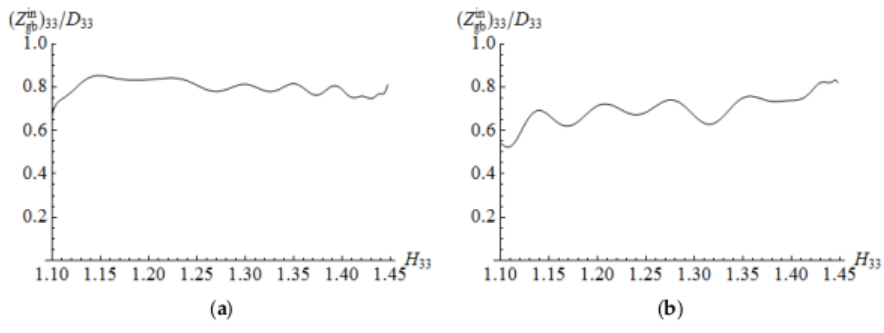
Figure 5. Inelastic strain rate values obtained at the expanse of the GBS ( Z in current strain rate D 33 and determined at equal intervals of the strain H 33 for the initial strain rate: